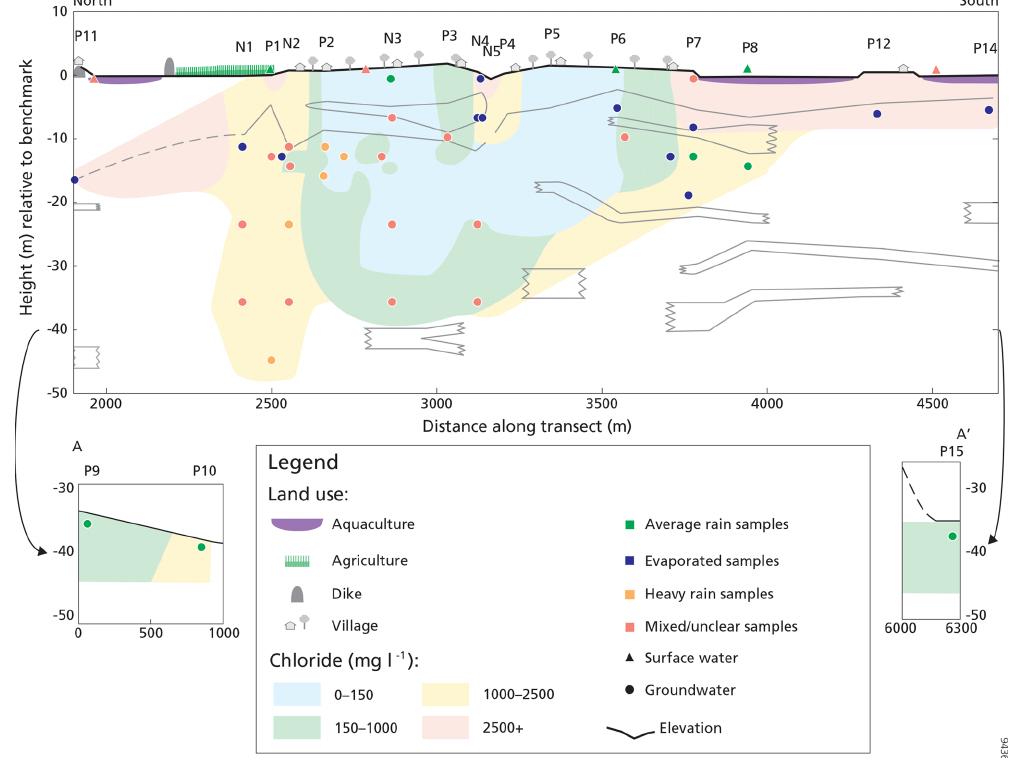
Figure 5. Isotope group of the groundwater sampled in the cross section. Table 2. Cation exchange groups